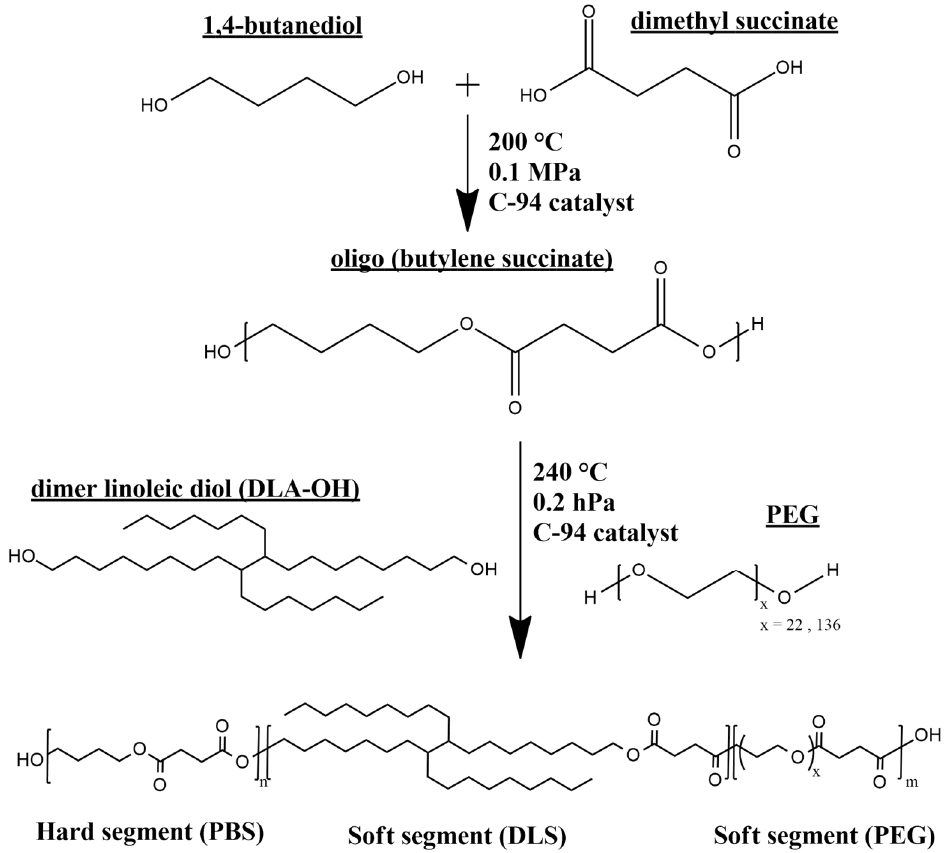
Figure 1. Schematic synthesis of PBS-DLS-PEG copolymers. Table 1. A summary of the synthesis conditions and copolymer compositions.